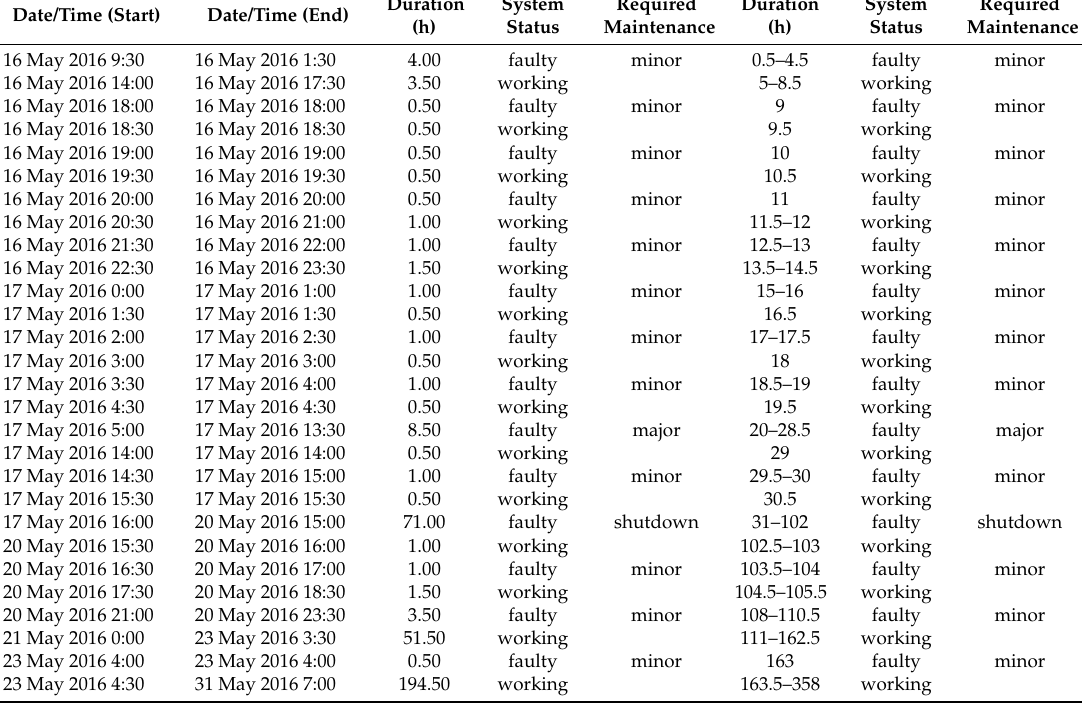
Table 6. Expected future status of the target component, the date and time the fault is expected, the duration of the fault and the requisite maintenance action required for the source